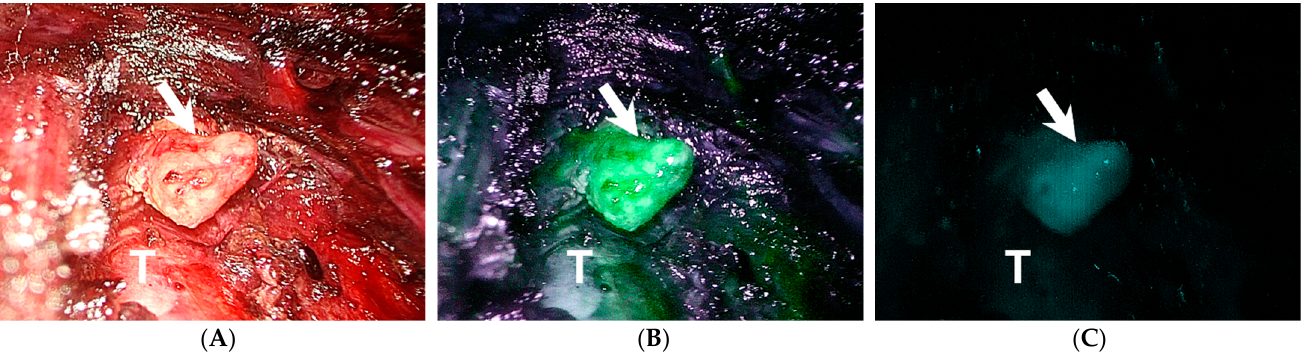
Figure 3. A right paratracheal lymph node (arrow) in a female patient with papillary carcinoma ( A ). It shows significant fluorescent intensity under indocyanine green angiography ( B , C ). Fluorescence from other tissues, such as lymph node or fat might sometimes interfere with the detection of parathyroid glands and misidentification can occur. Permanent section of this lymph node revealed reactive lymphadenopathy. T, trachea.